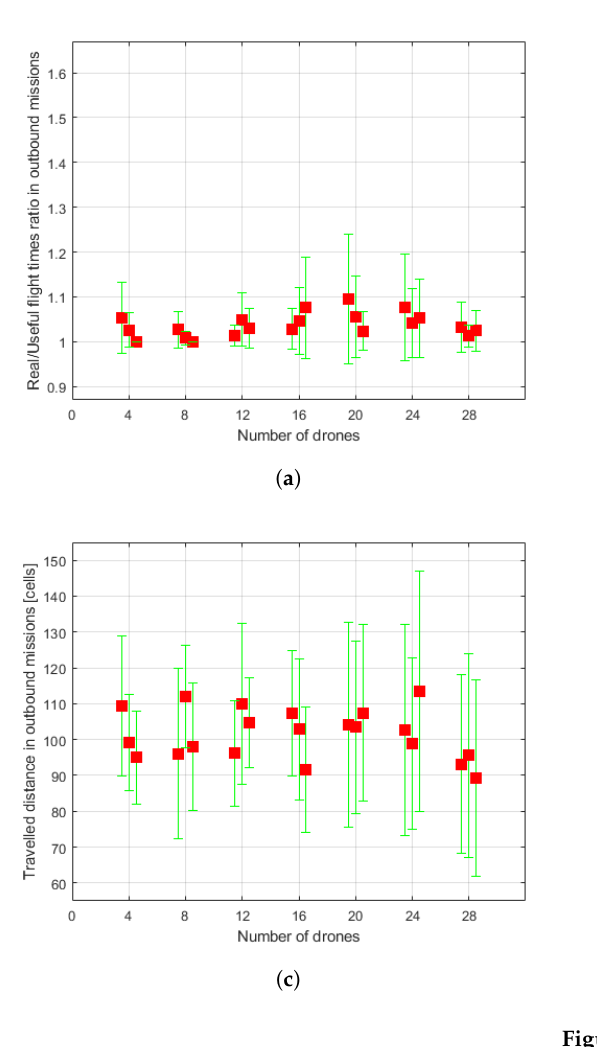
Figure 8. Statistical measures collected through simulations. Red squares represent mean values, while green ranges indicate mean absolute deviation. ( a ) Waiting time in depot in outbound missions. ( b ) Waiting time to take off in goal point to begin return mission.